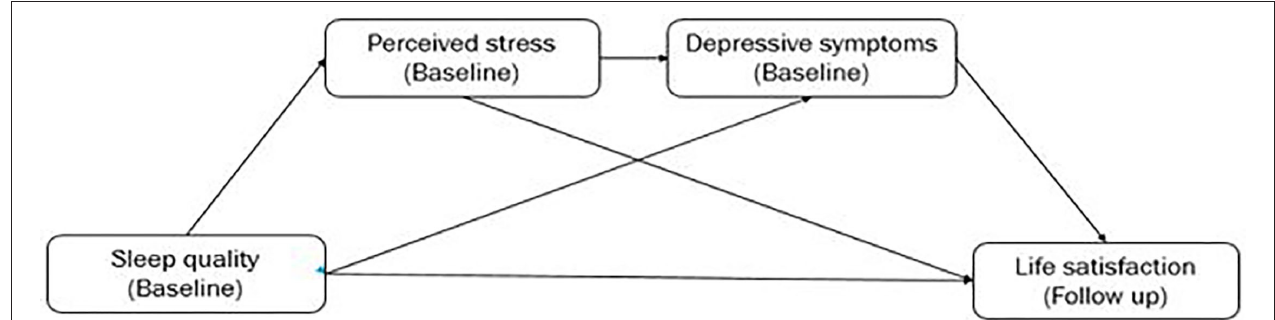
FIGURE 1 | The conceptual model of serial mediation with half-longitudinal study.